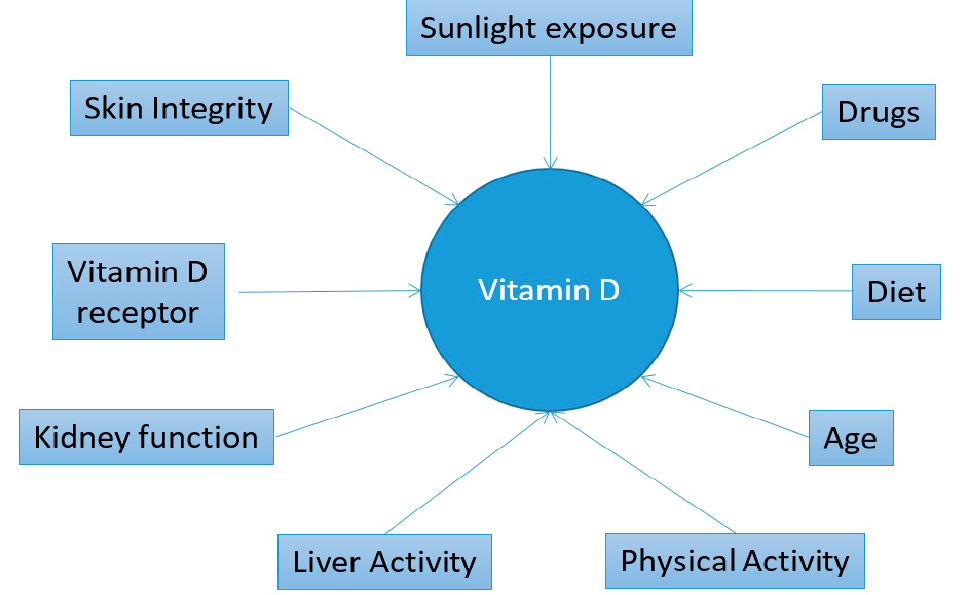
Figure 1. Factors influencing vitamin D levels.